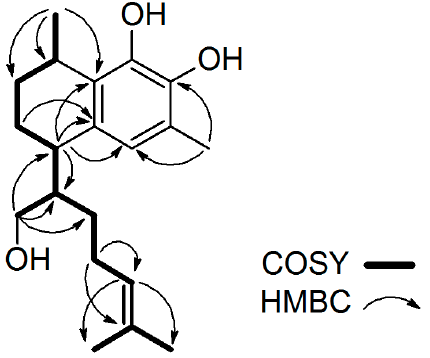
Figure 2. 1 H- 1 H COSY and HMBC correlations for compound 1 .